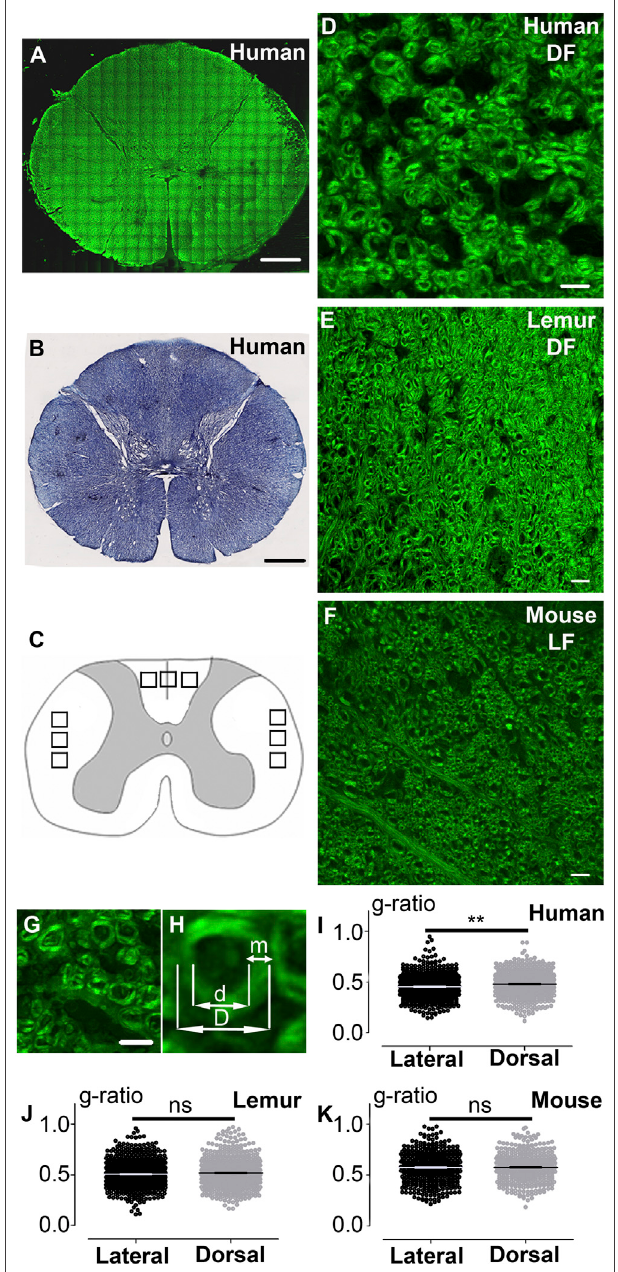
FIGURE 1 | CARS microscopy, a label-free method to visualize myelin andanalyzemyeling-ratiointhespinalcordofhumans,lemurs,andmice. Fast scanning mosaic of axial thoracic section of a human spinal cord imaged with CARS (A) ; this acquisition allows to locate where higher quality zoomed images were taken for further analysis. Human thoracic spinal cord stained with Luxol fast blue (B) . Schematic drawing of a spinal cord, black squares represent locations in the dorsal and lateral funiculi of quanti fi ed images in all species (C) . Humans (D) and lemurs (E) dorsal funiculus (DF), as well as mouse lateral funiculus (LF) (F) , were imaged with CARS. Human dorsal funiculus (G) . Higher magni fi cation of G and method used to measure the g-ratio (H) . Comparison of the g-ratio in lateral and dorsal funiculi in humans (I) , lemurs (J), and mice (K) . Data are mean ± SEM per fi bers. ** p < 0.005;